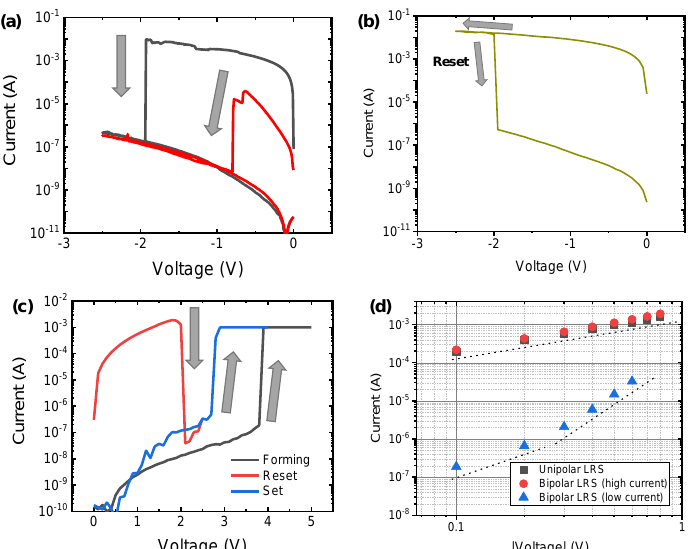
Figure 3. ( a ) Reset process including high-low-resistance state (LRS) current, low-LRS current, and HRS, ( b ) irregular reset process, ( c ) unipolar I–V curves including forming, set, and reset, and ( d ) log–log fitting of unipolar in the LRS and bipolar in the high LRS and low LRS for the Cu/Al 2 O 3 /Si device.